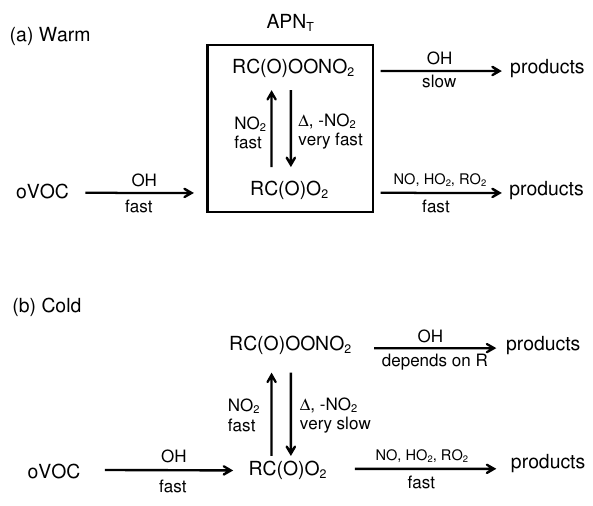
Scheme 1. 1APN chemistry schematic under warm (a) and cold (b) conditions. APN T is the sum of APN (RC(O)OONO 2 ) and the AP radical (RC(O)O 2